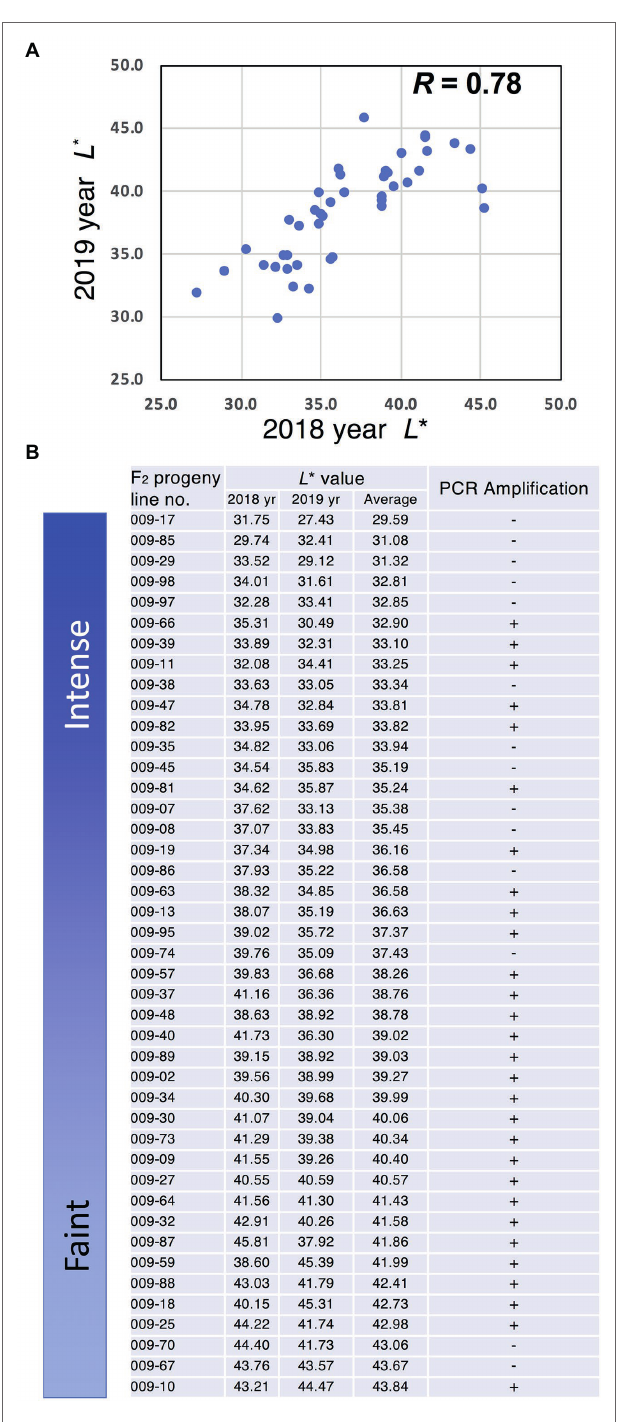
FIGURE 6 | Relationship between GtMIF1 and L * value. (A) L * value plots for 2 years. (B) PCR analysis of the GtMIF1 allele associated with faint-blue colour in F 2